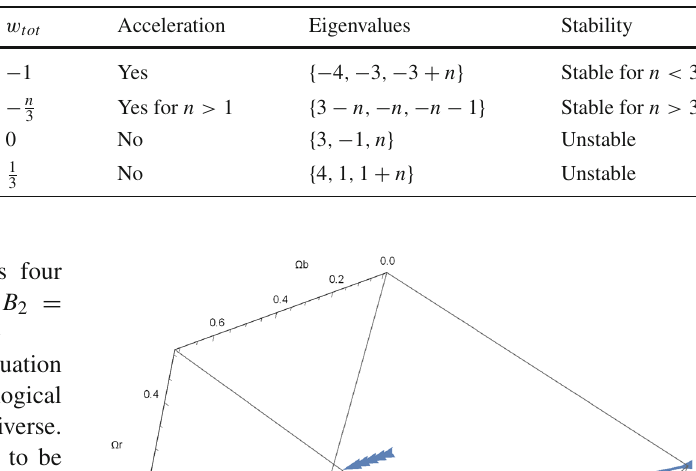
= 0 . 7, (cid:8) = 0 . 1, (cid:8) (cid:2) = 0 . 2, for b r